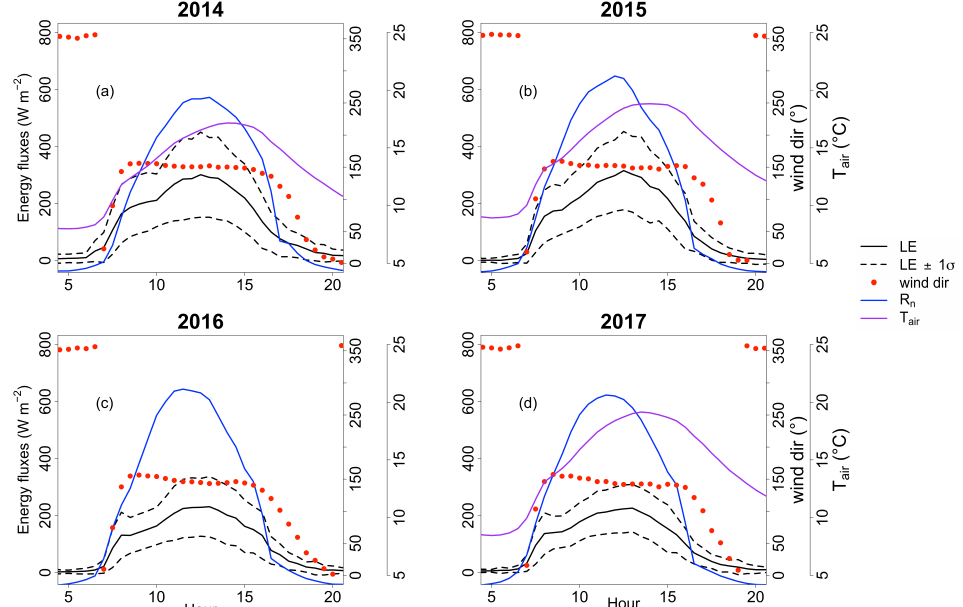
Figure 3. Growing season mean diurnal cycles at half hourly temporal resolution for latent heat flux ( LE ), net radiation ( R n ), wind direction and air temperature ( T air ). ( a ) 2014. ( b ) 2015. ( c ) 2016. ( d ) 2017. Dashed lines refer to LE ± 1 σ . The morning inflexion is visible in all the growing seasons for T air and LE